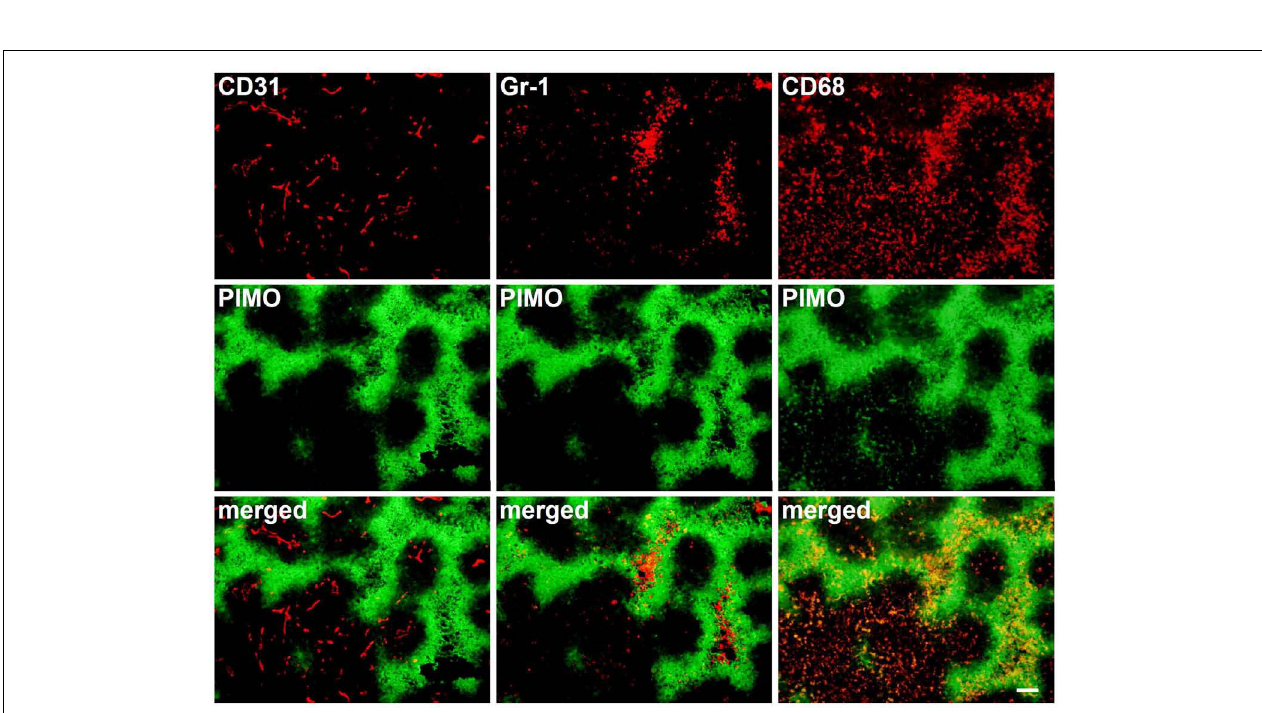
FIGURE 6 |The nature of PIMO + hypoxic region in control and irradiated tissues is different. The IHC staining for the distribution of hypoxia and vascular in control (A,C) , irradiated (B) , or pre-irradiated (D) ALTS1C1 tumors. The hypoxic regions in control tumors were vascularized.There was almost no